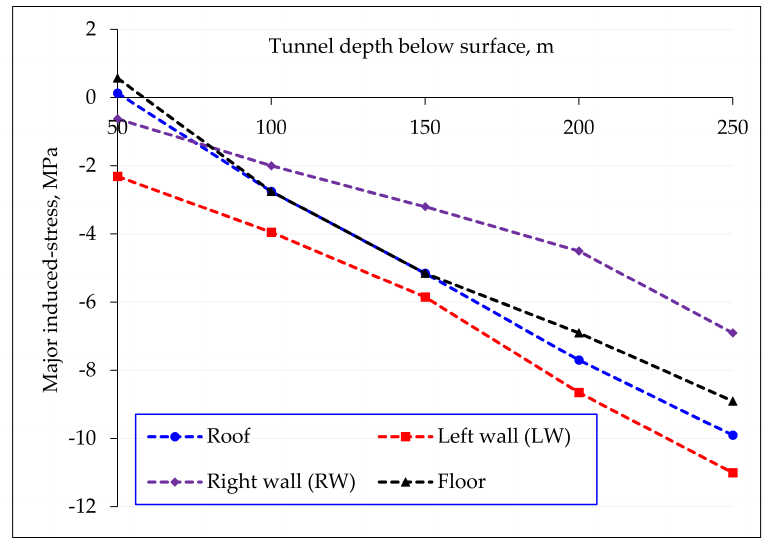
Figure 18. Induced-stresses around tunnel boundary at various depths below